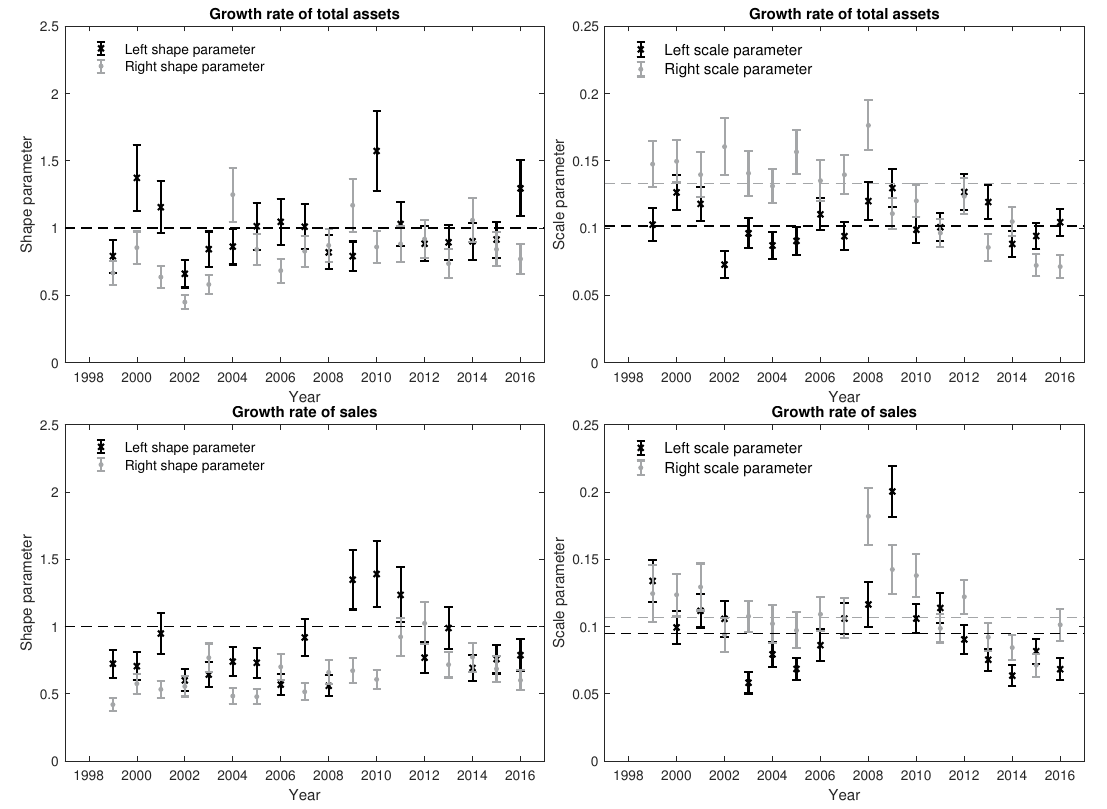
Figure 8. Estimates of the two shape parameters ( α l and α r ) and two scale parameters ( σ l and σ r ) for growth rates of total assets and sales. Results refer to the 200 largest long-lived firms according to their sales in 2016. Gray and black dashed lines refer to the median of the estimates of σ l and σ r ,